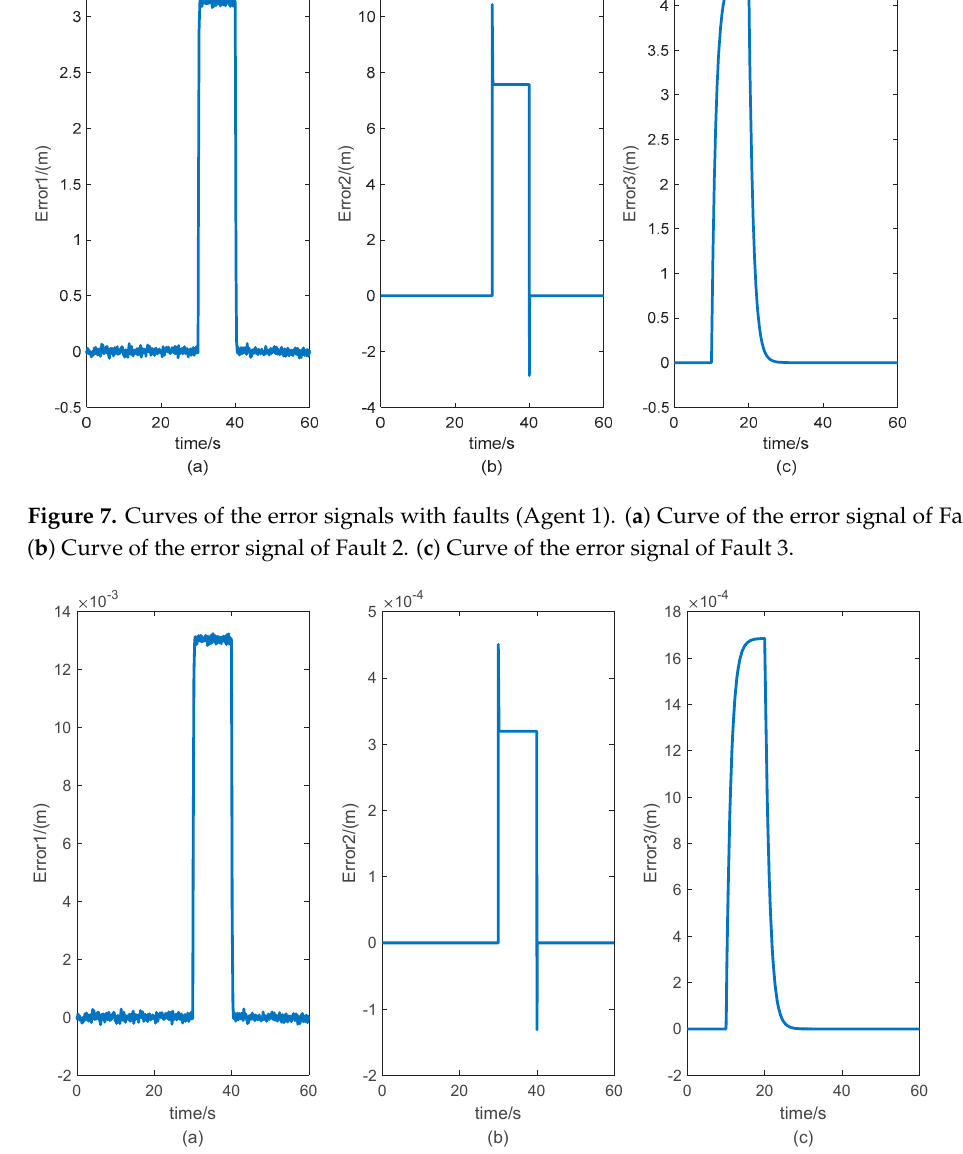
Figure 8. Curves of the error signals with faults (Agent 2). ( a ) Curve of the error signal of Fault 1. ( b ) Curve of the error signal of Fault 2. ( c ) Curve of the error signal of Fault 3. Table 1. The verification of parameter φ .